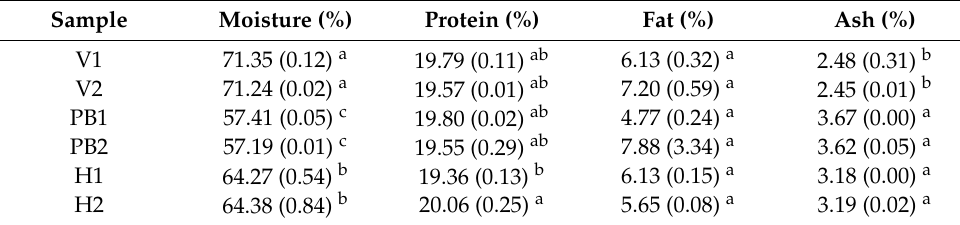
Table 1. Proximate composition (mean value (standard deviation)) of the samples.